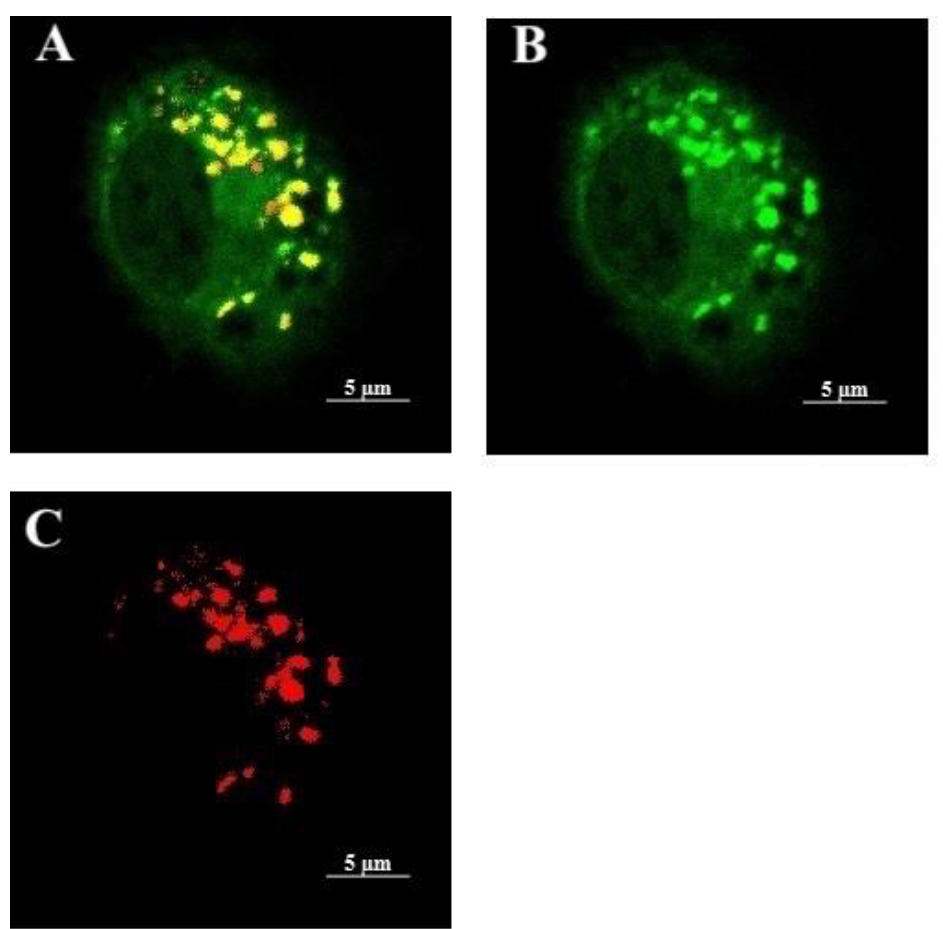
Figure 2. Distribution of DiBAC4(3) (Ex/Em 493/516) and Lysotracker Red (Ex/Em 577/590) in live AM. ( A ) Overlay, ( B ) DiBAC4(3), and ( C ) Lysotracker Red. The lysosomes were labeled simultaneously with 300 nM DiBAC4(3) and 50 nM Lysotracker Red. The colocalization relative to Lysotracker was measured using a Zeiss LSM 880 confocal microscope. The concentration of dyes was shown to be optimal after 1 h incubation. Fourth, the sensitivity of this assay for detecting measurable changes in lysosomal membrane potential was examined. For this purpose, lysosomal membrane potential was manipulated with either Valinomycin, a specific K + ionophore, or Bafilomycin A1, a selective inhibitor of vacuolar H + -ATPases responsible for lysosome acidification, as discussed in the Methods [28]. Valinomycin is a specific K + inophore, which incorporates into both plasma membrane and lysosomal membranes [34,35] increasing K + permeability across the lysosomal membrane [22] and facilitating K + efflux from cytosol to extracellular fluid [36]. Therefore, valinomycin was used as an inducer of lysosomal hyperpolarization. The increased K + efflux hyperpolarizes the lysosomal membrane [23]. Hyperpolarization of the lysosomal membrane of AM after treating with different doses of Valinomycin (100 nm, 2 µ M, and 20 µ M) was detected using this assay (Figure S6A). Wang et al. showed that removal of lysosomal H + resulted in an increase in lysosomal pH and decreased lysosomal membrane potential [34]. Therefore, in this study, Bafilomycin A1 was used as a positive control of lysosomal membrane potential reduction due to the effect of H